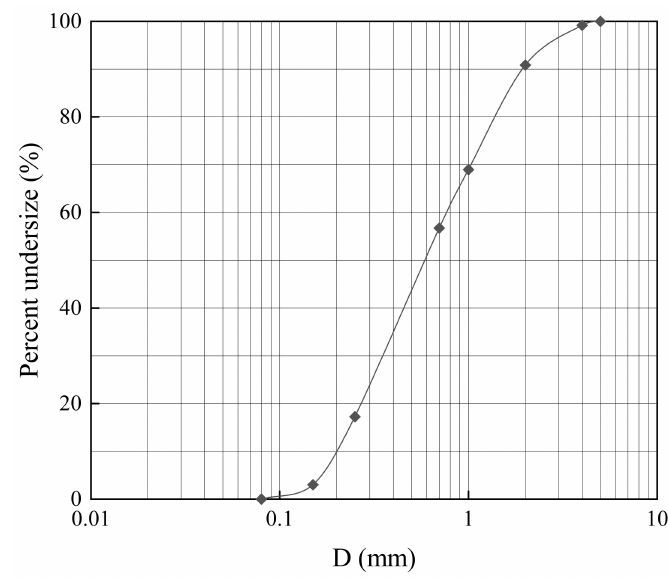
Figure 4. Grain-size distribution curve.